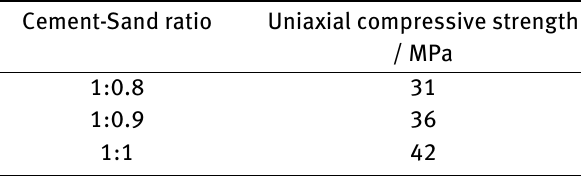
Table 2: Physical and mechanical parameters of similar material Gravity Compressive strength / (kN · m −3 ) / MPa 2.73 42 5.6 33